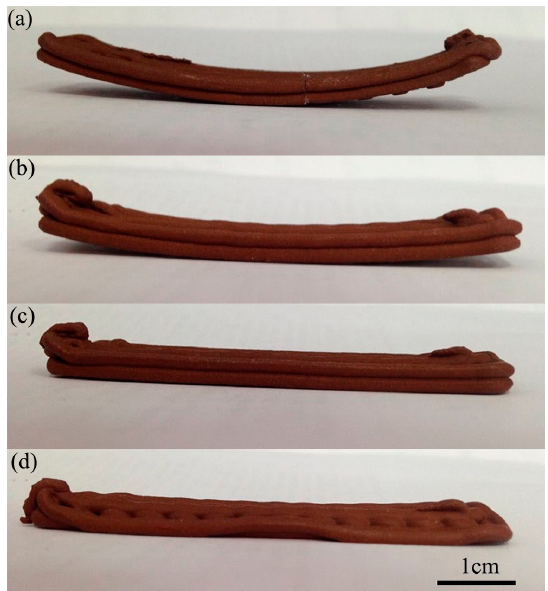
Figure 8. Green samples printed by a novel additive manufacturing method with: ( a ) the temperature of the substrate 30 °C; ( b ) the temperature of the substrate 50 °C; ( c ) the temperature of the substrate 70 °C; ( d ) the temperature of the substrate 90 °C.